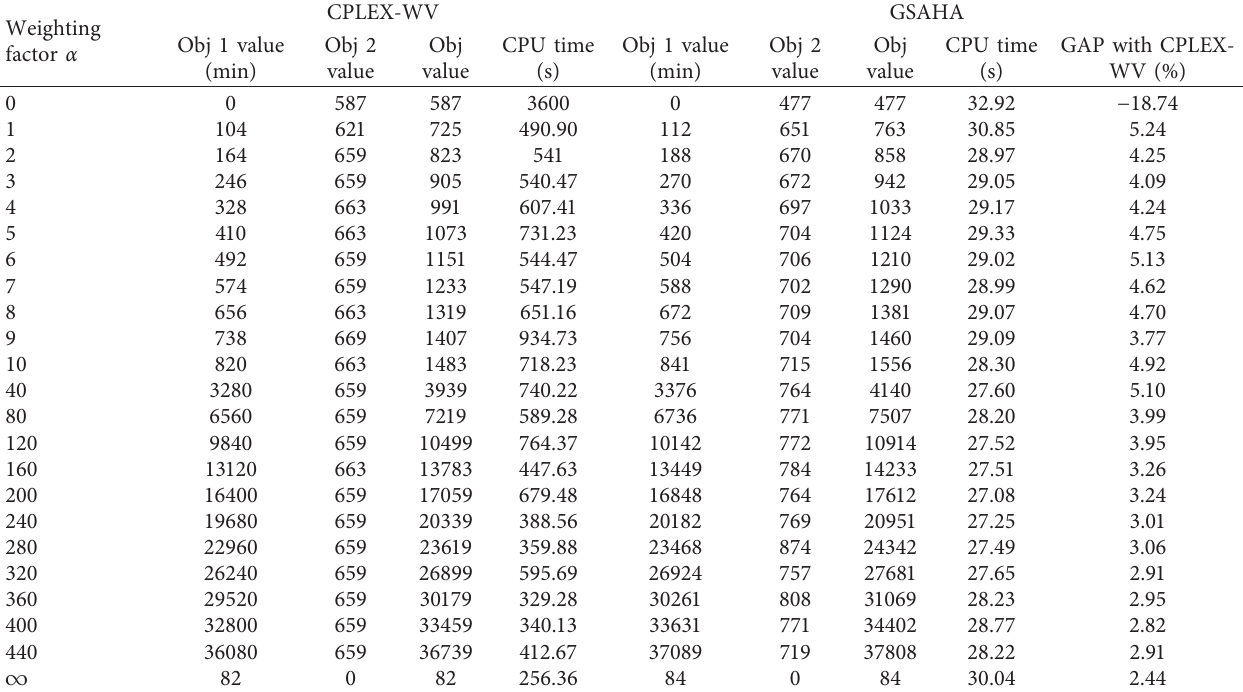
Figure 10: Convergence process of GSAHA for the scenario (70, 10, 0). Table 12: Optimization results of CPLEX-WV and GSAHA with different values of weighting factor α